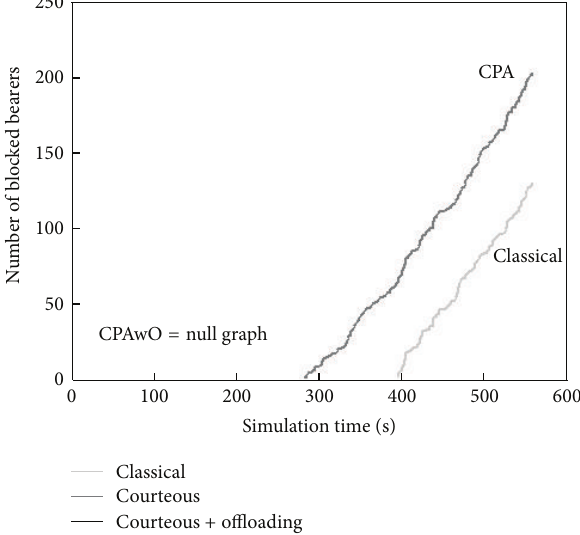
Figure 10: Number of PS nonemergency blocked bearers.